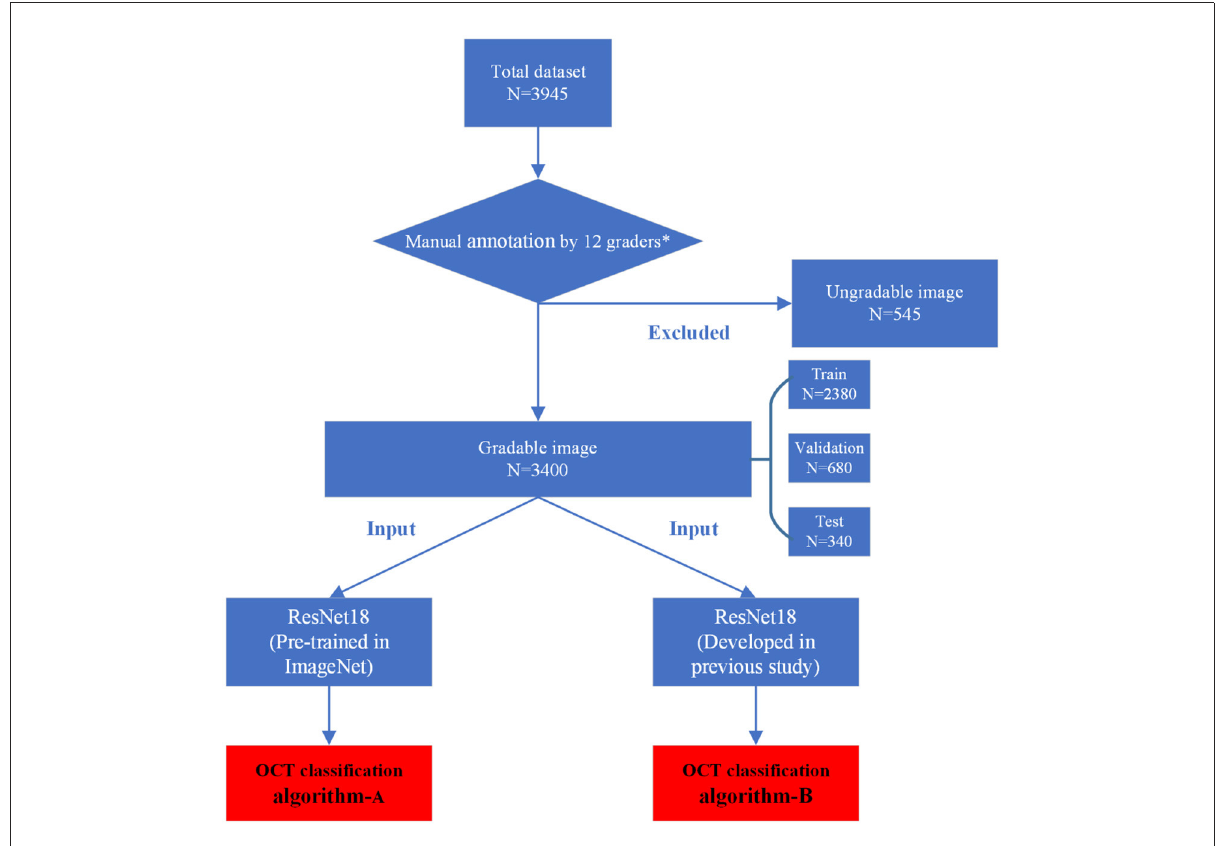
FIGURE2 Workflow diagram showing the overview of the development